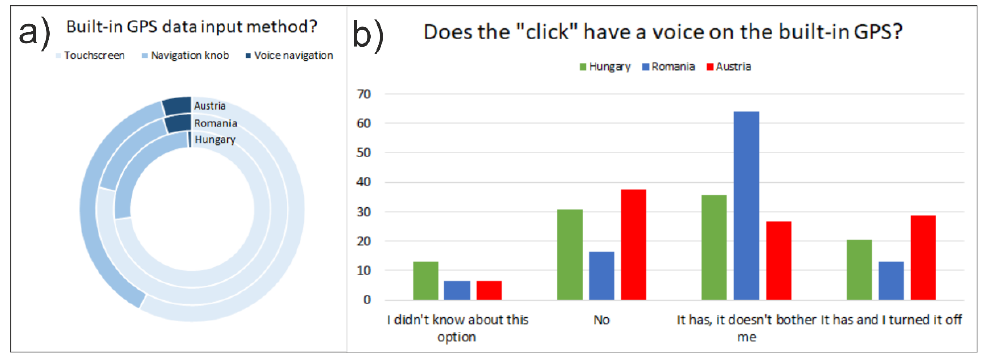
Figure 4. Answers about the sound effects II: ( a ) possible data input methods and ( b ) appearance of the “click” sound.